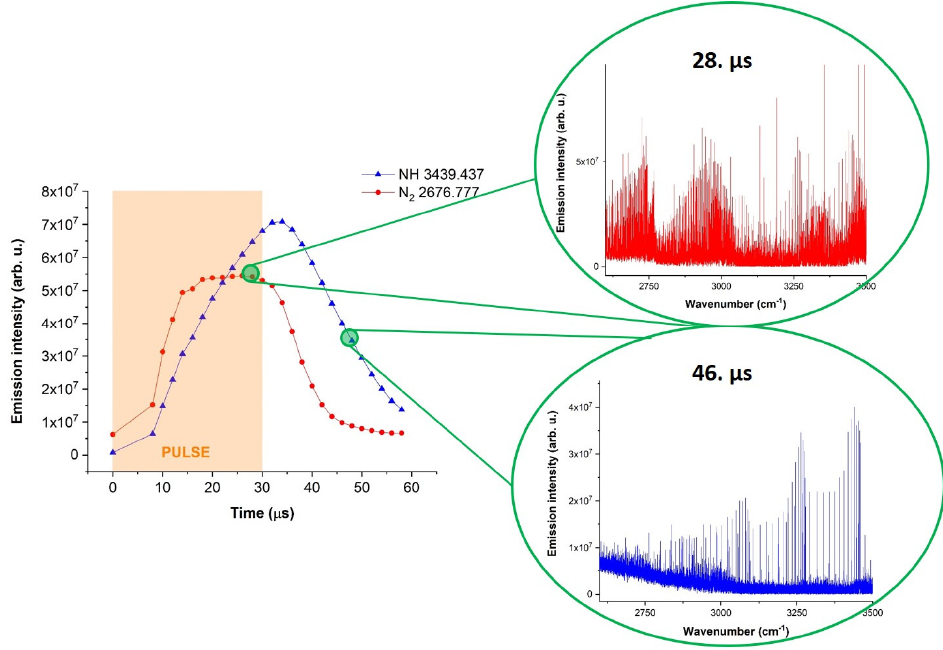
Figure 15. Time pro fi les of NH radical and N 2 and the appearance of spectra at speci fi c times. Figure 15. Time profiles of NH radical and N 2 and the appearance of spectra at specific According to the time pro fi le curves in Figure 15, it is possible to observe that both species gain energy in the discharge pulse (30 µs here). After the pulse, nitrogen starts to lose its energy faster than the NH radical, which lives slightly longer as a result of possible mutual energy exchange. At the 28th microsecond, which is still in the discharge pulse, the overall spectrum (in the red color) is depicted in the right top corner of Figure 15. This spectrum is completely occupied by nitrogen, and it is di ffi cult to distinguish any NH radical lines here. The right bo tt om corner of Figure 15 demonstrates the spectrum (in blue color) of the 46th microsecond of the measurement. As can be seen, the spectrum contains no residual nitrogen bands, and only the NH radical is present. It is very di ffi cult to dis- tinguish NH from nitrogen by the use of non-time-resolved FTIR spectroscopy since ni- trogen covers all other lines due to its omnipresent nature in the middle IR region. Nev- ertheless, by the application of time resolution, both species are separated in time and are, therefore, easily recognized in their pure form. Through the use of time-resolved FTIR spectroscopy, we were also able to measure several pure rotational lines of NH ( v = 0). According to our best knowledge, this meas- urement is one of the fi rst experimentally observed pure rotational NH lines in the labor- atory by the use of a cold source. As can be seen in Figure 16, pure rotational lines of NH radical are situated in the range of approx. 700–900 cm − 1 and are resembled in triplets. Our spectral resolution, 0.02 cm − 1 , was not enough to separate individual peaks, and their approximate position had to be estimated by the deconvolution of the whole triplet.